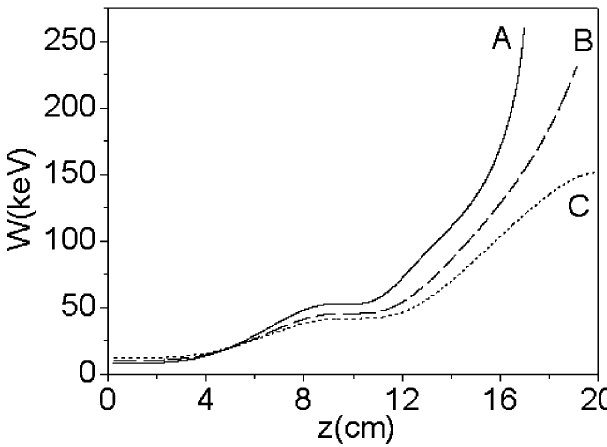
FIG. 6. Spatial evolutions of the electron energy for different initial longitudinal energies: (A) W (cid:1) 12 keV . (C) W i